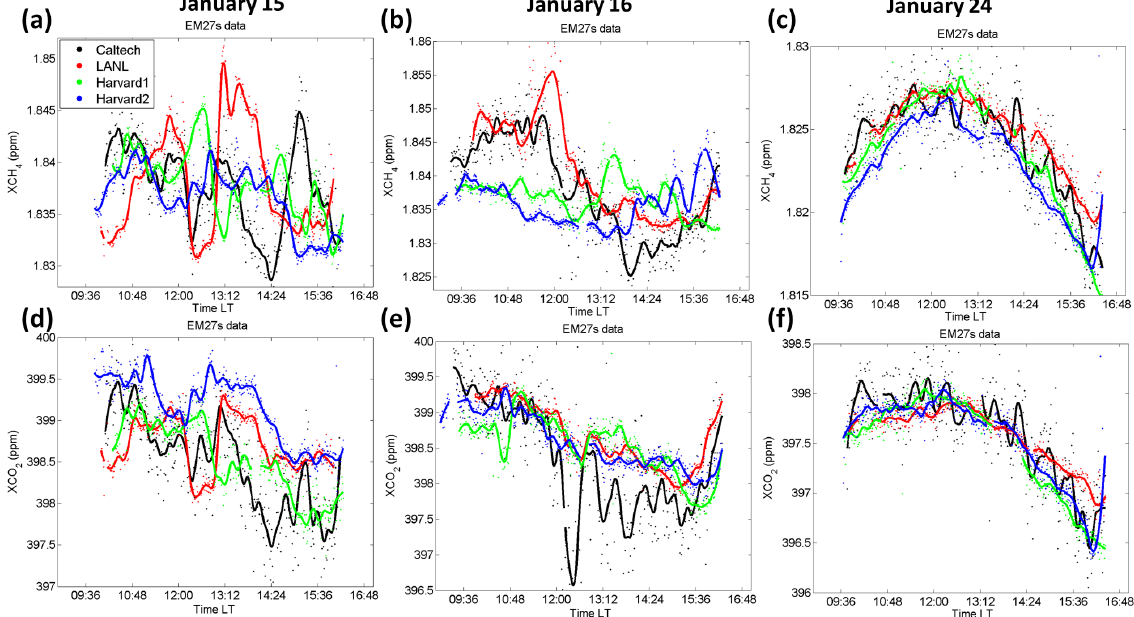
Figure 3. One minute average time series of X CH marks correspond to the Caltech, LANL, Harvard1, and Harvard2 spectrometers,